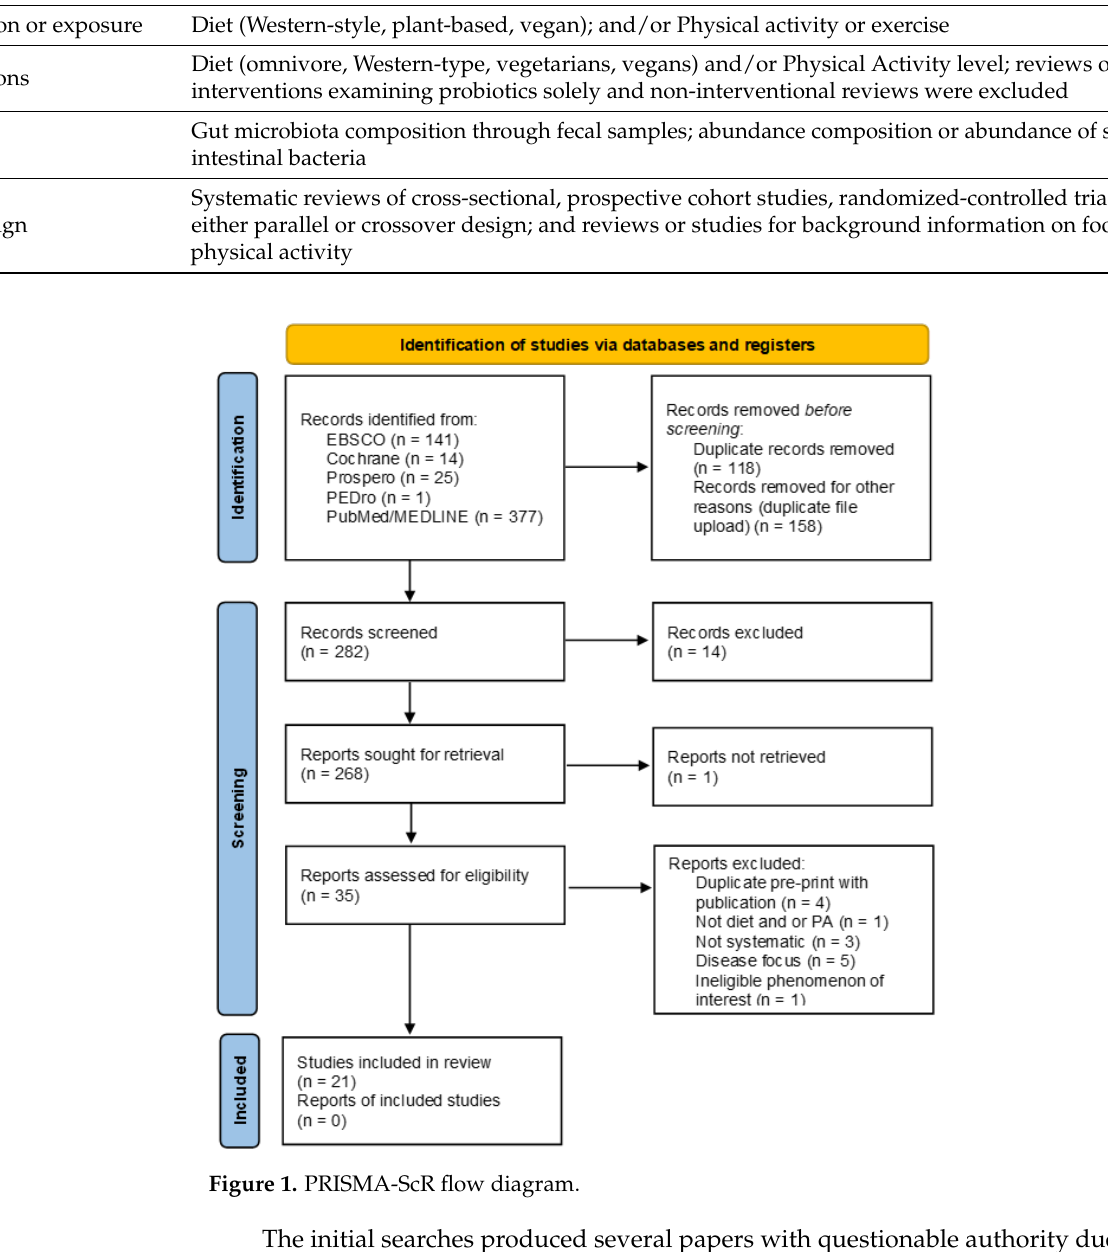
Figure 1. PRISMA-ScR flow diagram.